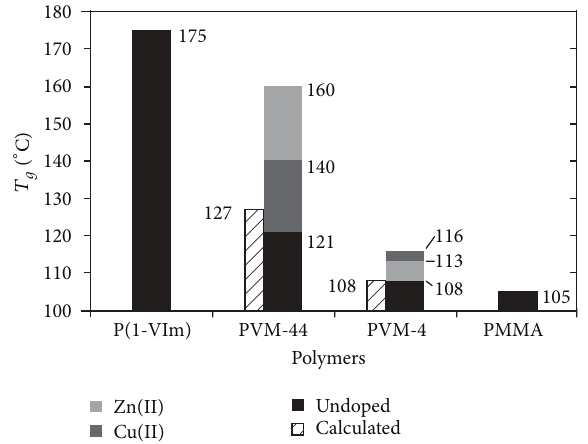
Figure 3: Glass transition of polymers and polymer complexes